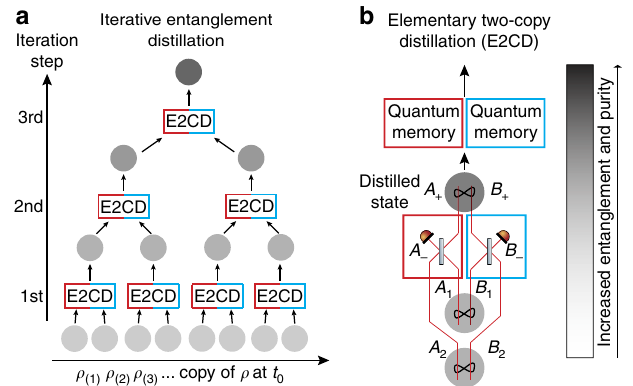
Figure 1 | Iterative entanglement distillation. ( a ) At each elementary step of the protocol, two copies of the input state, described by the density matrices r , are combined to produce, with some probability, one output copy with better properties. ( b ) Elementary step of iterative Gaussification of two-mode continuous-variable quantum states. Alice’s and Bob’s modes locally interfere on balanced beam splitters and one output mode on each side is measured with a photodetector. The procedure succeeds if both modes are projected onto vacuum. A quantum memory was previously deemed necessary for an efficient implementation of such an iterative protocol as one must store the successfully distilled states in a quantum memory to make them available for subsequent distillation